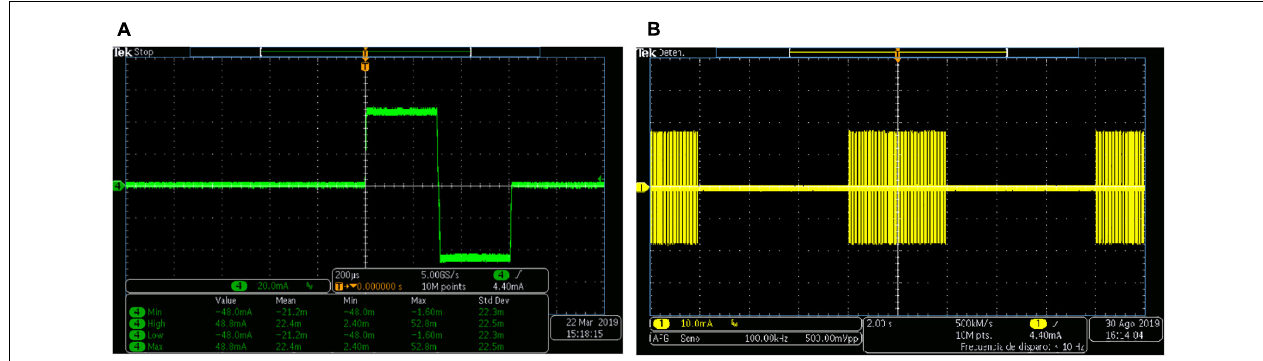
FIGURE 4 | Biphasic stimulation pulses obtained with the PG-nFES. (A) A single stimulation pulse, with 48 mA amplitude (96 mA peak to peak) and 200 µ s pulse width. (B) Bursts of stimulation pulses, with burst-time of 4 s ON, 6 s OFF, and peak amplitude of 16 mA.